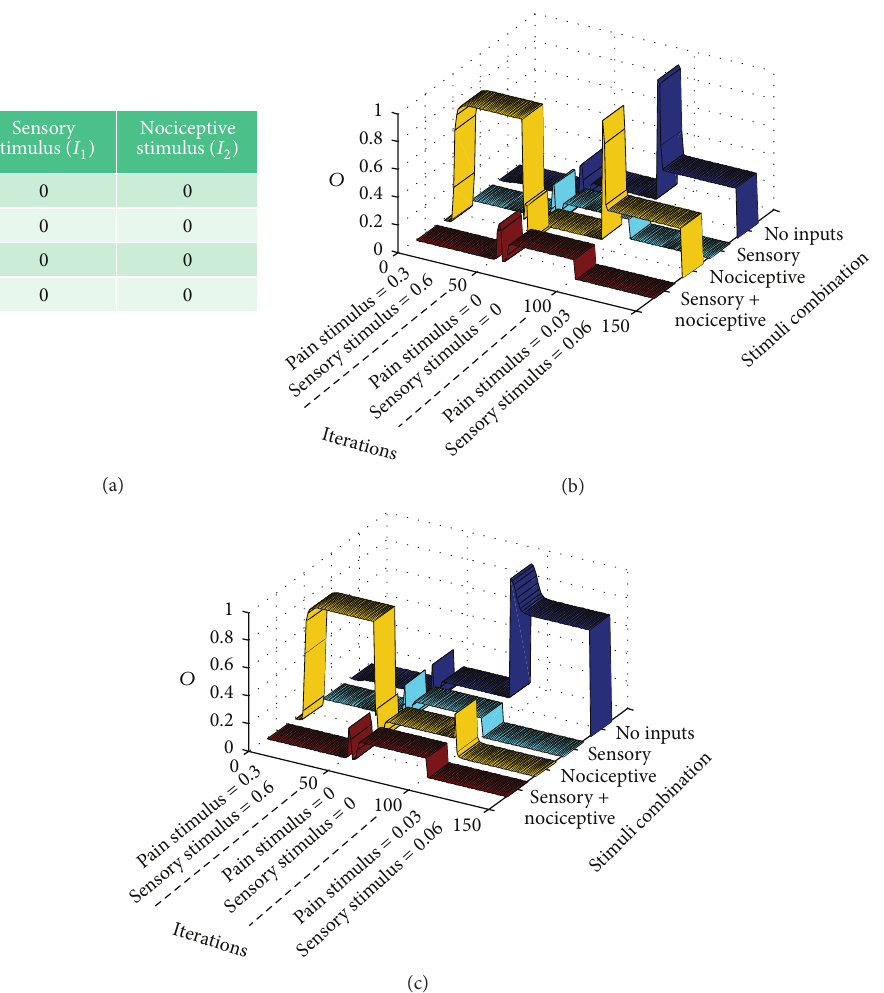
Figure 7: Modeling phantom limb pain: after presenting a standard training epoch to the gate model during 50 iterations, (a) a null training epoch is input to the gate along 50 more iterations in order to model the period after amputation. (b and c) After 100 iterations, very weak input signals are input to the gate model. Graphs correspond to two stability points. Both graphs show that pain signals are emitted from CT neurons in a situation in which there are no inputs to the gate in a condition known as dysesthesia (blue ribbon). Graph (b) shows a situation of a setpoint in which weak nociceptive inputs elicit a pain signal from CT neurons (yellow